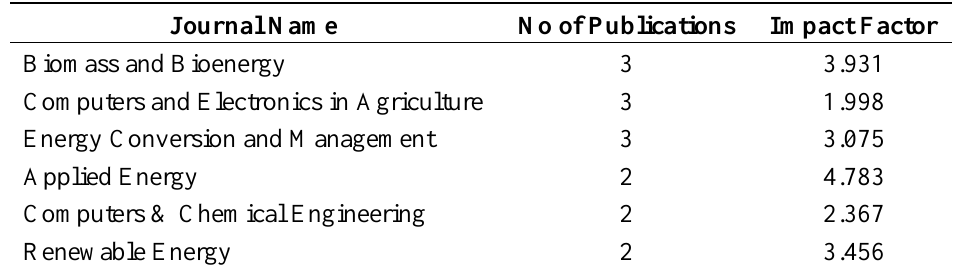
Table 4. Top six journals in terms of